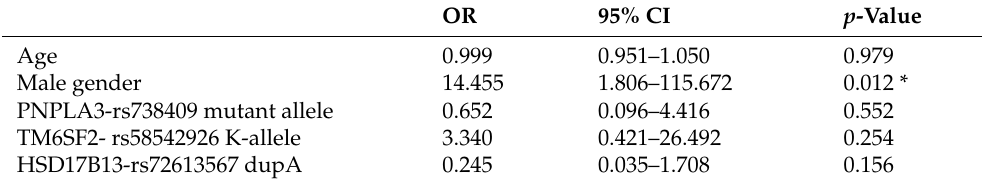
Table 4. Factors associated with